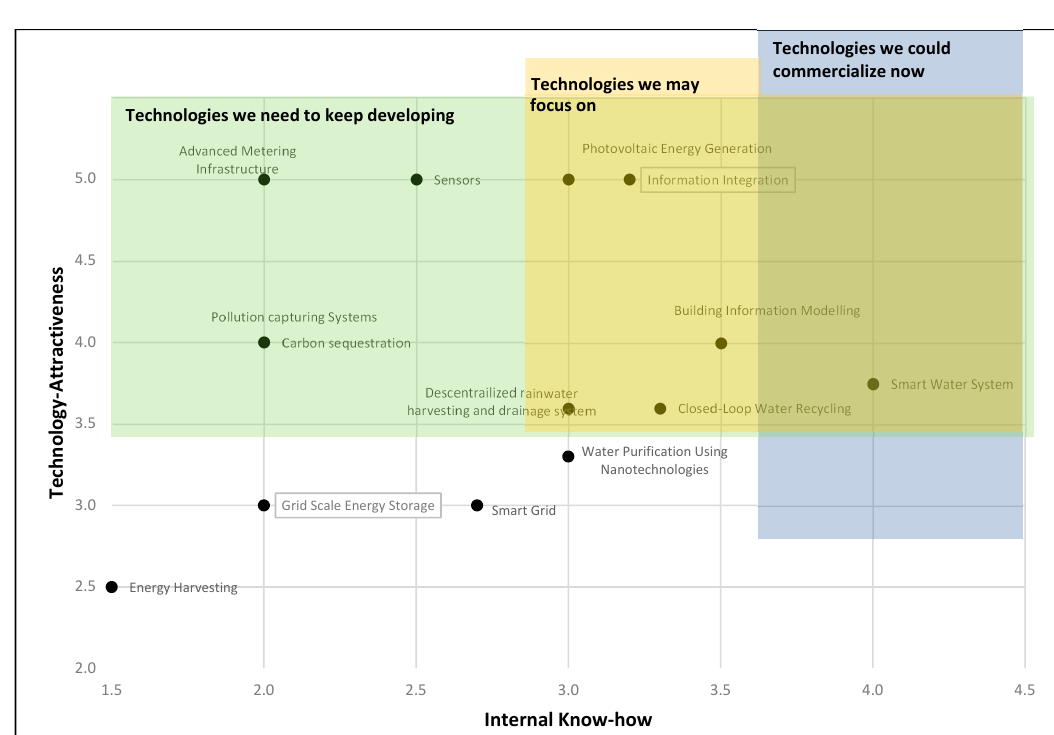
Figure 2. Technology attractiveness vs. internal know-how. Figure 3. Technology attractiveness vs. internal